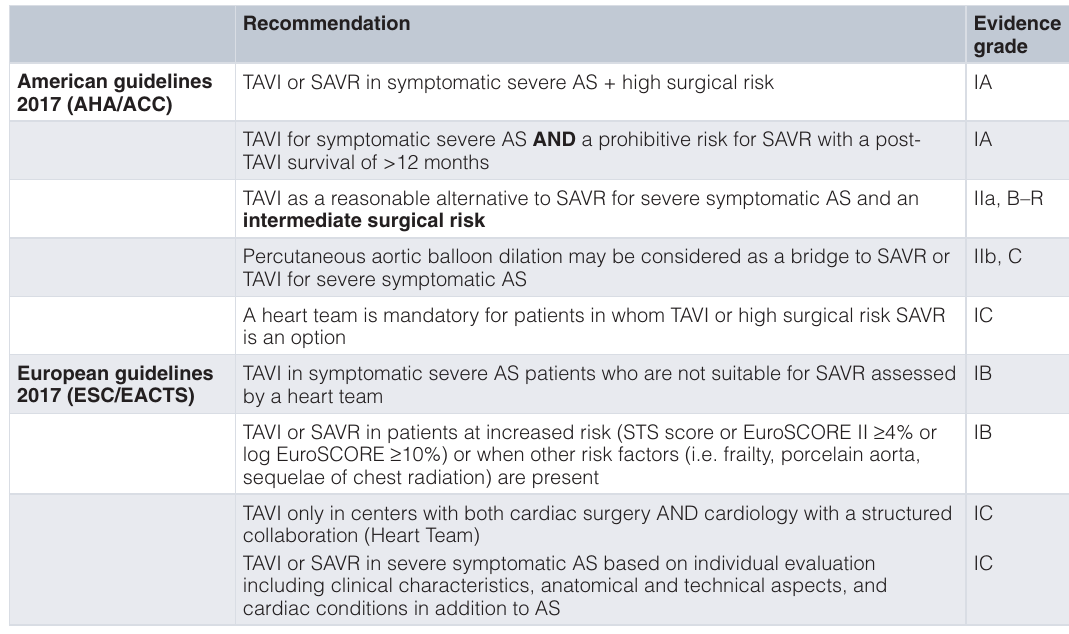
Table 1. Guidelines of treatment for aortic stenosis (AS).